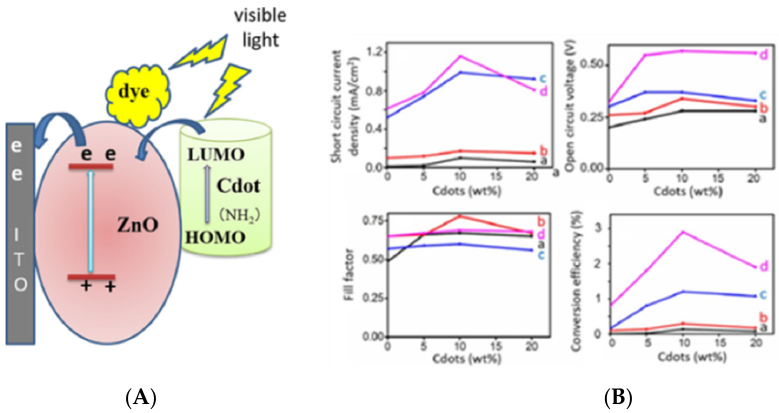
Figure 14. ( A ) Schematic illustration of anode in dye sensitized solar cell (DSSC). ( B ) Plots of electrochemical parameters from ZnO@Cdots/dye DSSCs as a function of Cdots content for ( a ) ZnO(100)@Cdots(1)/RhB, ( b ) ZnO(20)@Cdots(1)/RhB, ( c ) ZnO(100)@Cdots(1)/N719, and ( d ) ZnO(20)@Cdots(1)/N719. Reprinted with the permission of Reference [110]. Copyright 2019 Elsevier Ltd.